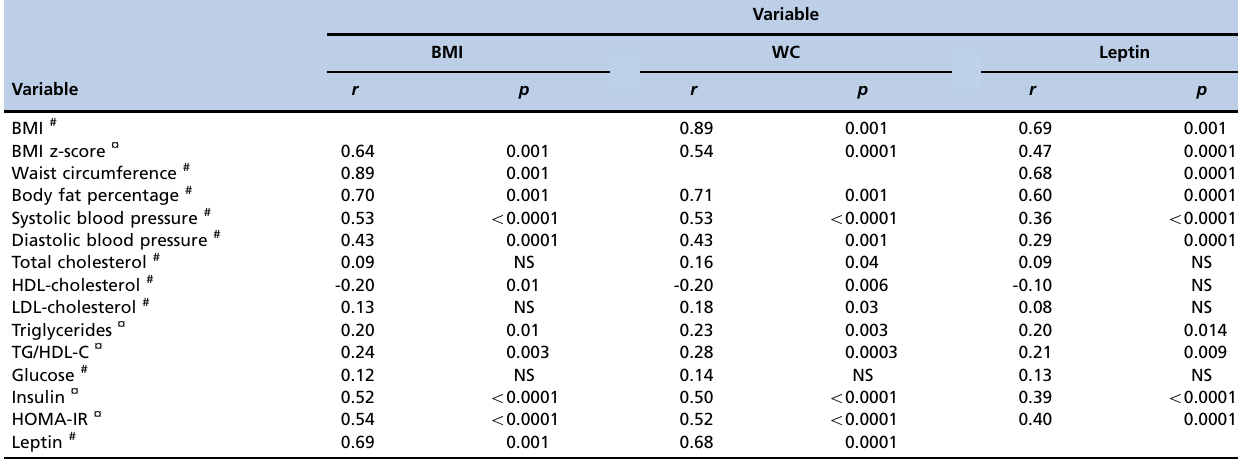
Table 4 - Simple linear correlation ( r ) between clinical, laboratory and leptin parameters in overweight and obese children and adolescents recruited from the public schools of the Municipality of Uberaba, Minas Gerais State, Brazil, from February 2013 to July 2014.